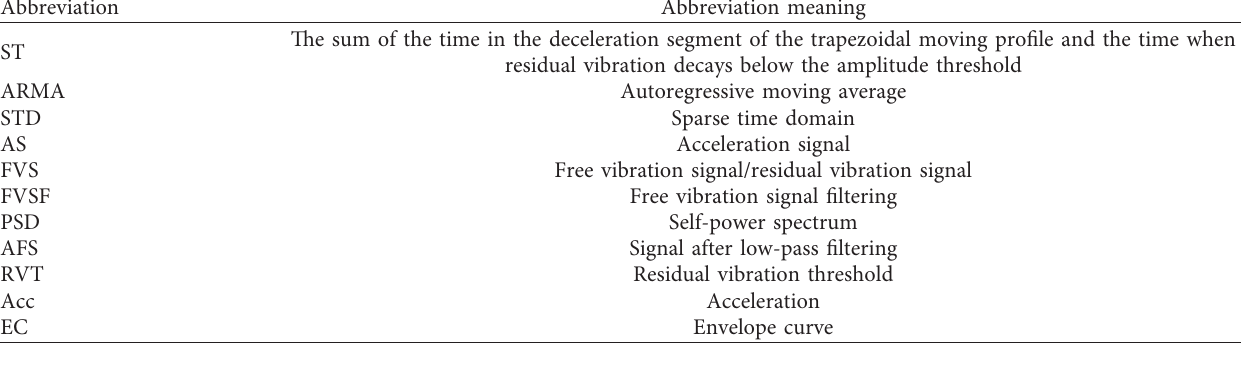
Table 1: Abbreviation description.